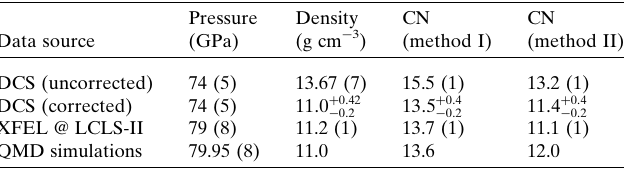
Table 2 Densities and coordination numbers for liquid tin from different datasets.